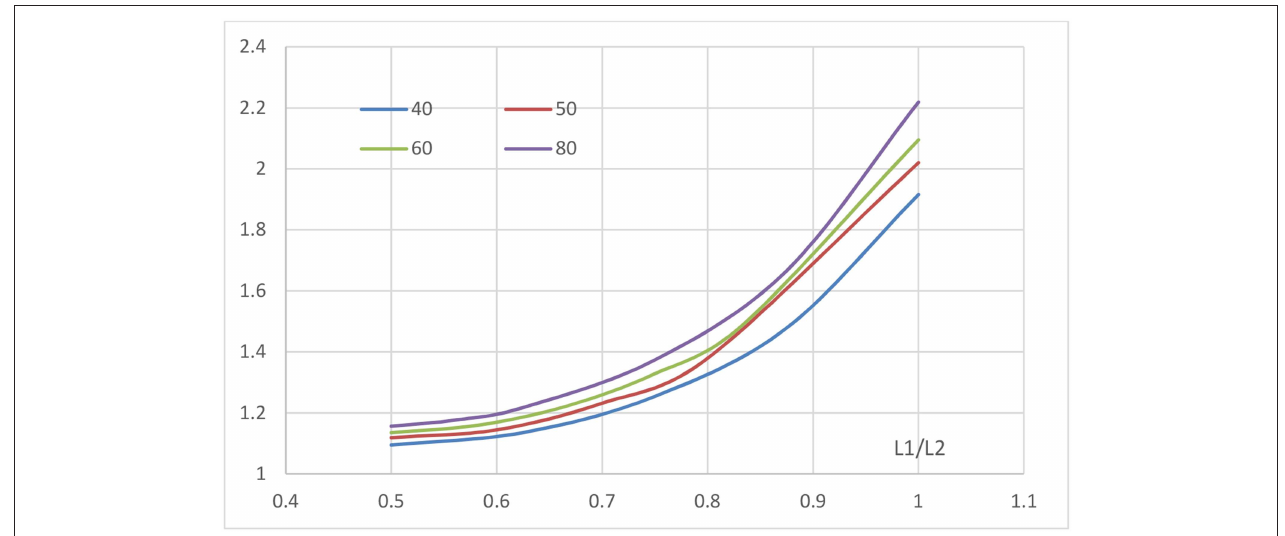
FIGURE 8 | Total bending moment support section vs. span